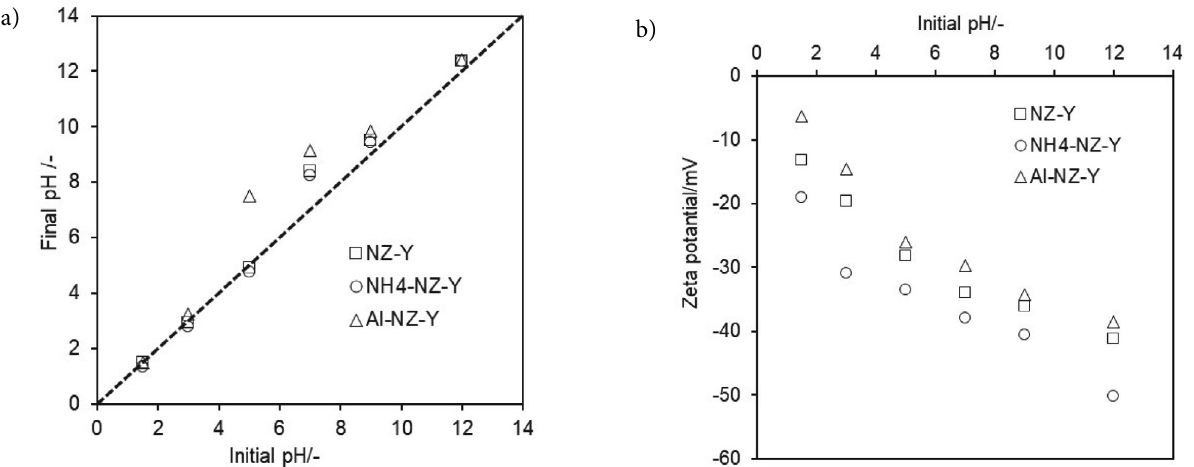
Figure 2. pH variation (a) and zeta potential (b) of natural and modified